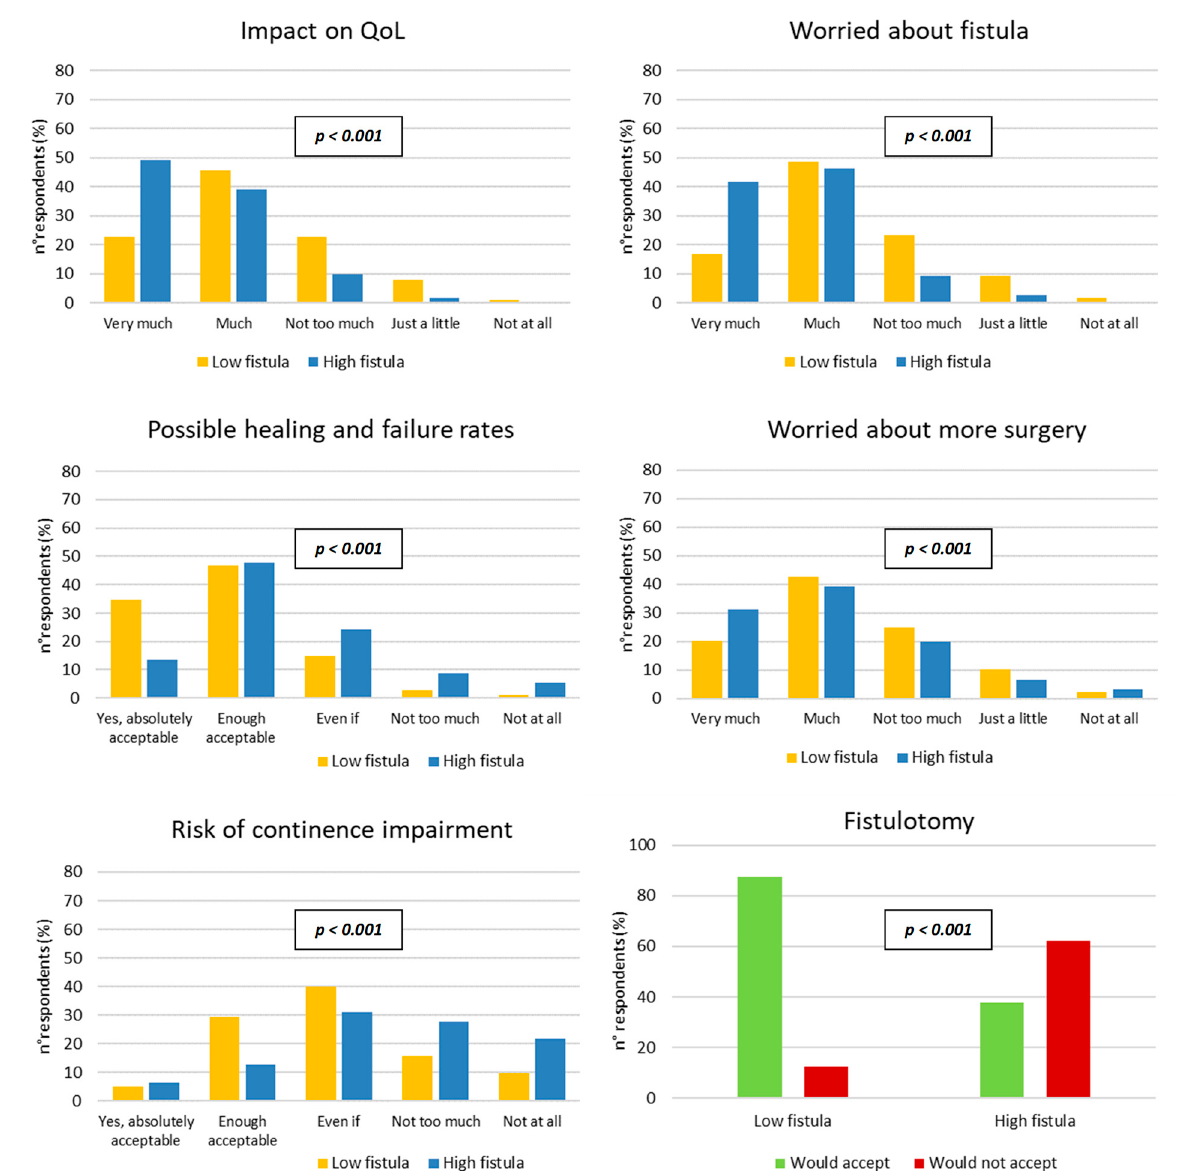
Figure 1. Surgeons’ responses to the questionnaire regarding low and high anal fistulas (chi-squared test). QoL = quality of life; Even if = considerable. Table 2. Relationship between respondents’ characteristics and the choice to accept fistulotomy in both low and high fistula (chi-squared test). The p -value in bold was statistically significant.